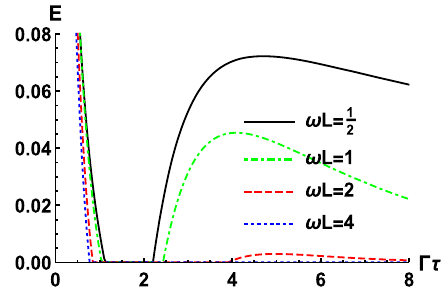
Fig. 1 Entanglement as function of Γ τ with different atomic separa- tions for initial Werner state with p =2/3, ν = 2, a /ω = 1 / 2 and ω r = 1